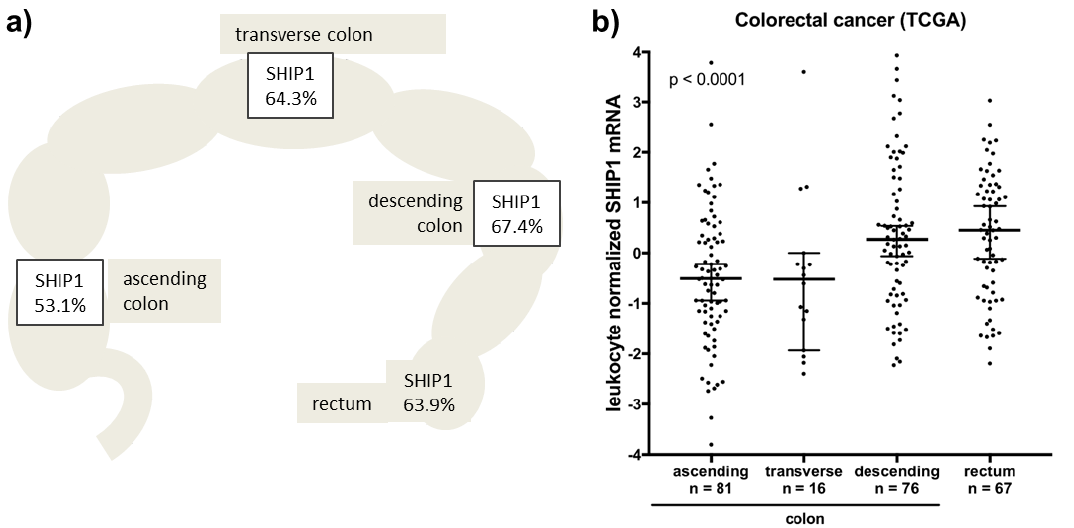
Figure 3. SHIP1 expression is correlated with left-sided colorectal cancer. ( a ) Moderate and strong SHIP1 protein expression (Figure 2a) is significantly related to left-sided tumor localization ( p = 0.0127). ( b ) SHIP1 mRNA expression (from TCGA) was normalized to leukocyte markers and analyzed for association with colorectal cancer localization ( p < 0.0001).